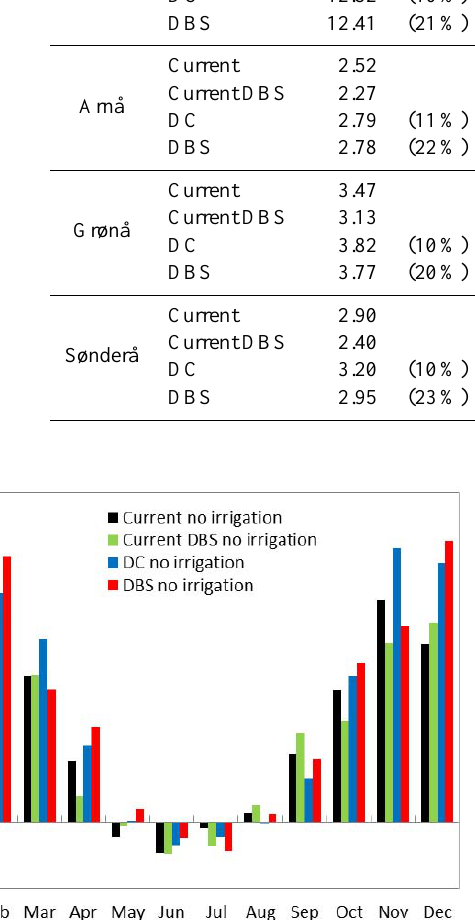
Fig. 10. Distribution of average daily groundwater